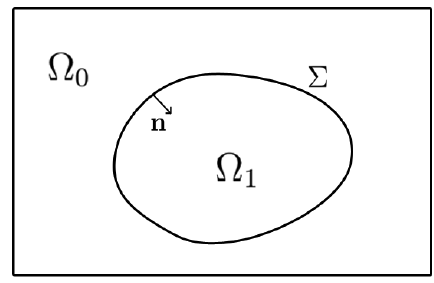
Figure 1. Definition of the